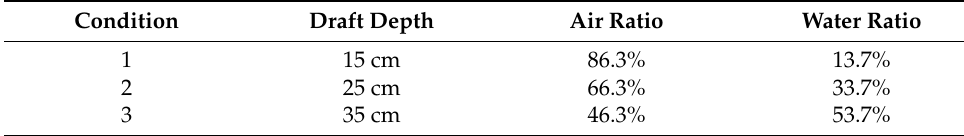
Table 3. Draft depths used for the TBJF.